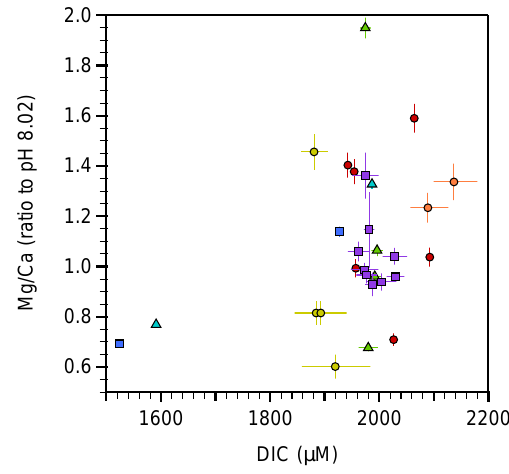
Figure 2. Foraminifera Mg / Ca variation with dissolved inorganic carbon. See Fig. 1a, b for legend.